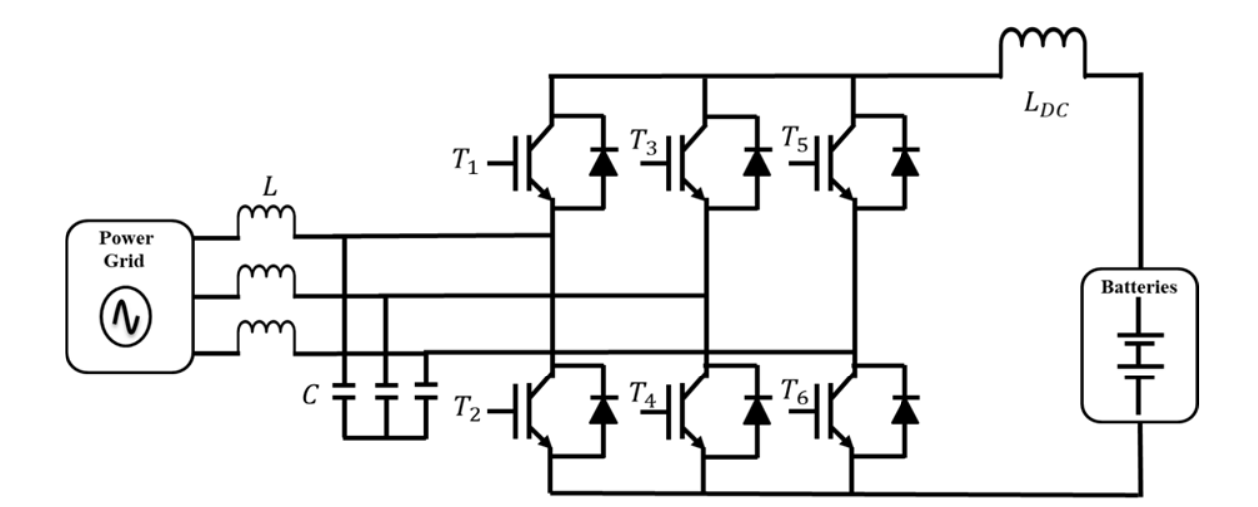
Figure 10. Current source-controlled EV fast charger topology.